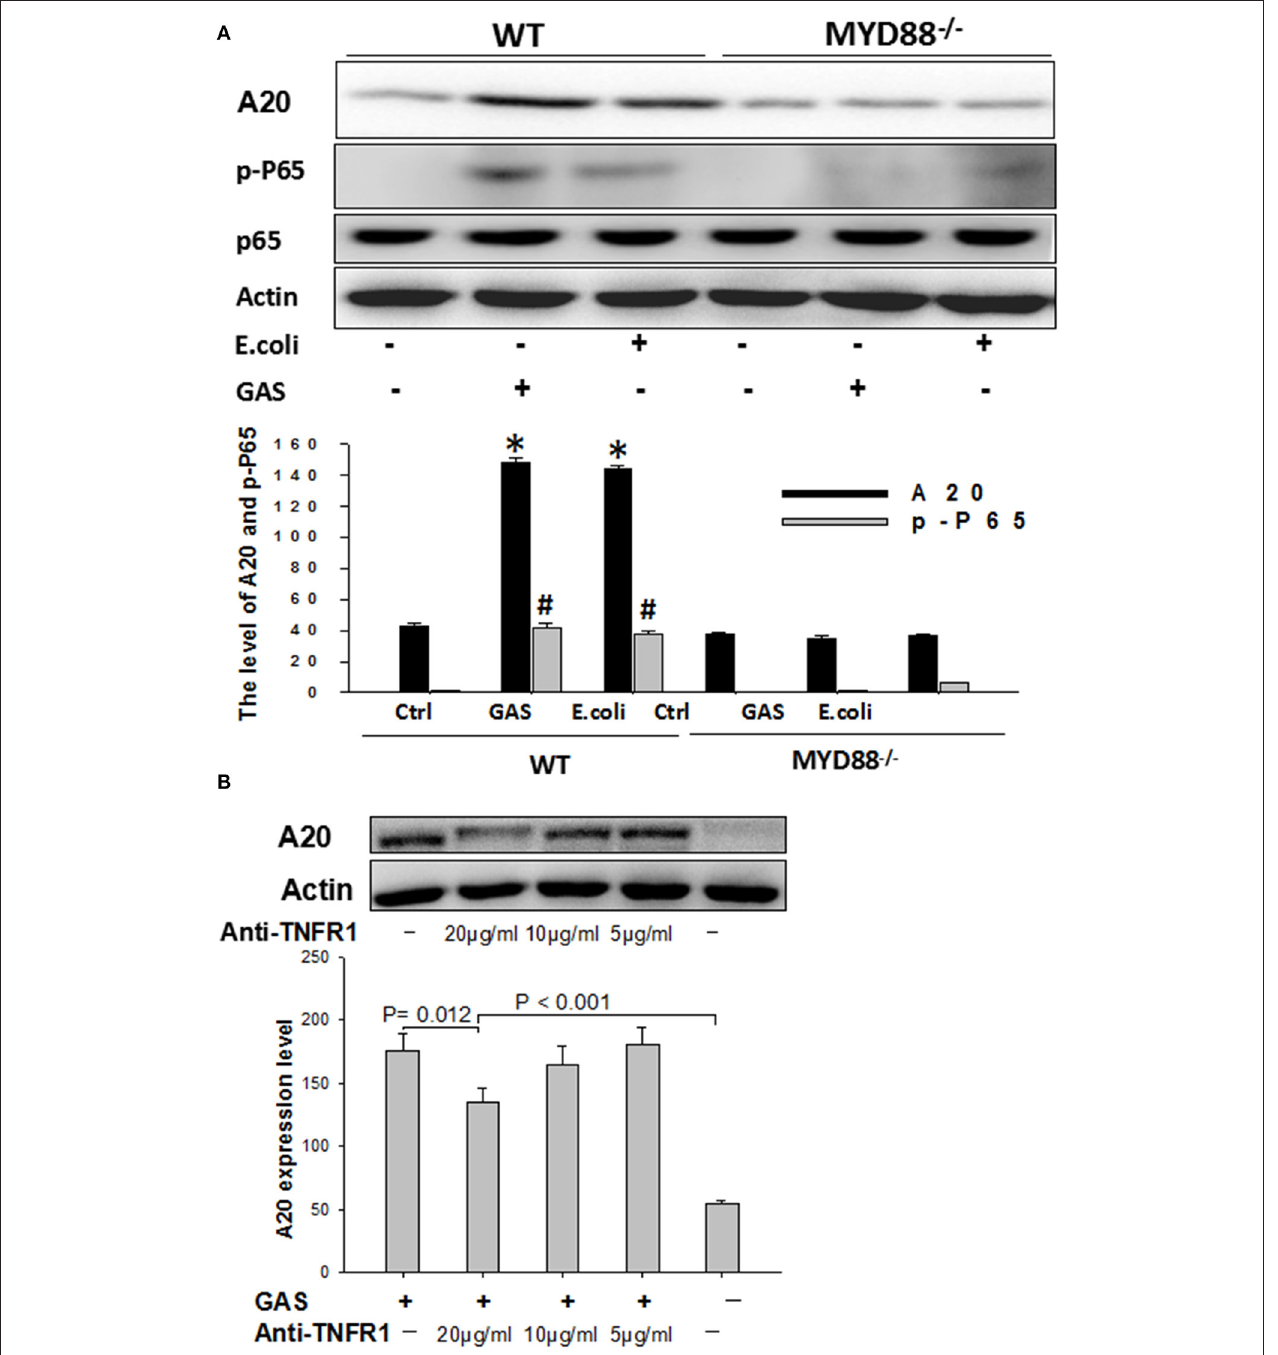
FIGURE 6 | Western blot analysis of A20 expression in wild type or MyD88-/- BMDMs stimulated with GAS, and the detection of A20 expression following blockade with anti-TNFR1. BMDMs from MyD88 − / − knockout mice were stimulated with GAS at an MOI of 10. Six hours later, the treated cells were collected and determined by Western blotting using antibodies targeted to A20, p-P-65, and β -actin (A) . * P < 0.05 and # P < 0.001 vs. MyD88 − / − group. RAW cells were blocked with anti-TNFR1 monoclonal antibody for 30min and then stimulated with GAS at an MOI of 10 for 6h, following collection of the treated cells, A20 expression was detected by Western blotting (B) . Each experiment was repeated three times, and similar results were obtained on each occasion.